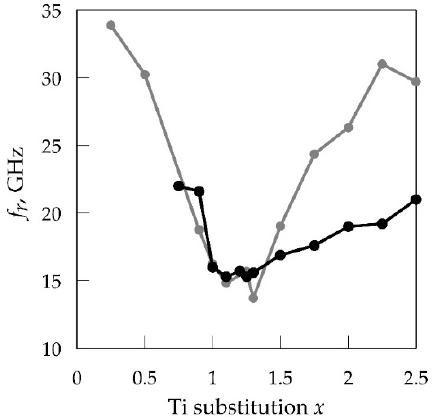
Figure 8. The resonance frequency plotted against the substitution level x . The black dots are measured values, the grey dots are calculated by Equation (1), the lines are guides for the eyes.